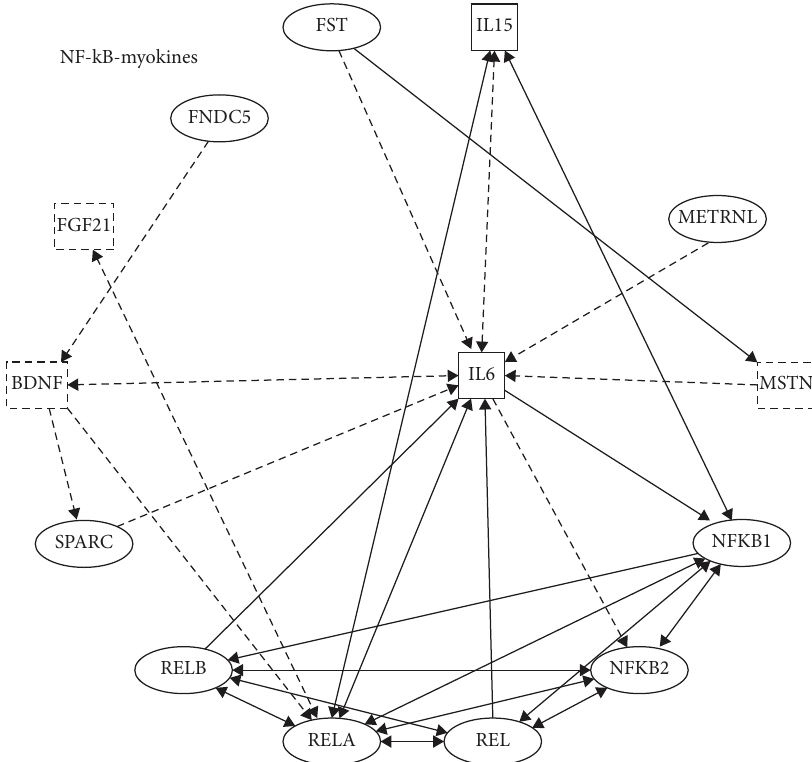
Figure 4: NF- κ B and myokines. IPA showed the molecular pathways of myokines and NF- κ B. IL-6: interleukin-6, IL-15: interleukin-15, BDNF: brain-derived neurotrophic factor. Solid lines indicate direct regulation; dashed lines indicate indirect